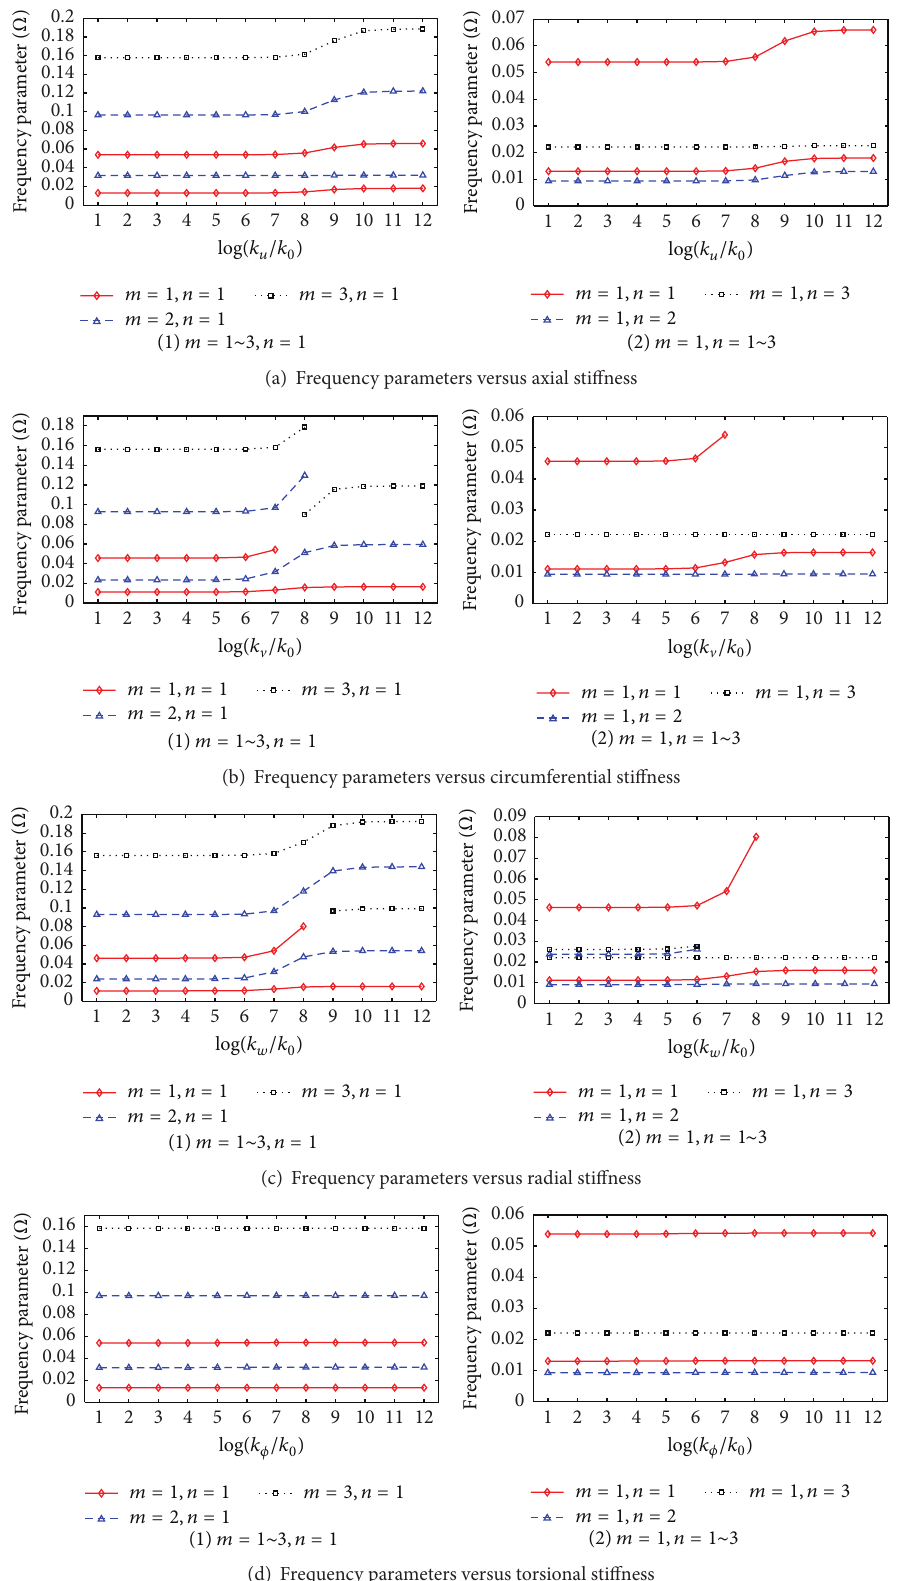
Figure 6: Effect of elastic-support stiffness on the frequency parameters for the elastic-support boundary conditions (elastic-support stiffness 𝑘 = 1 × 10 7 N/m or